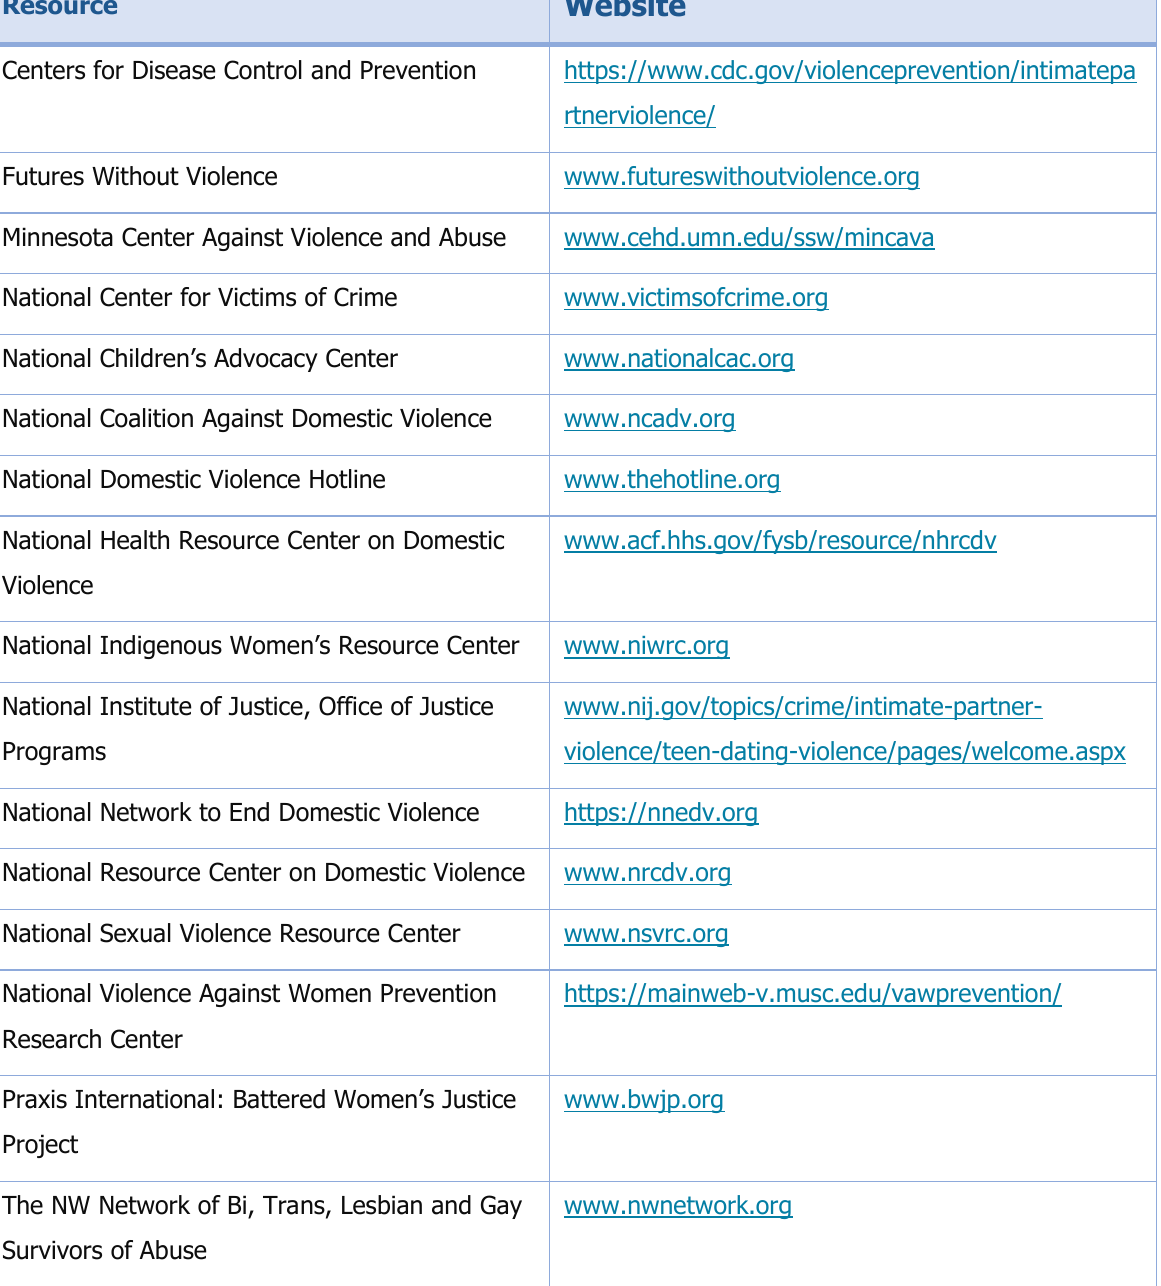
Table C1. Domestic Violence Resources for Youth Development Professionals